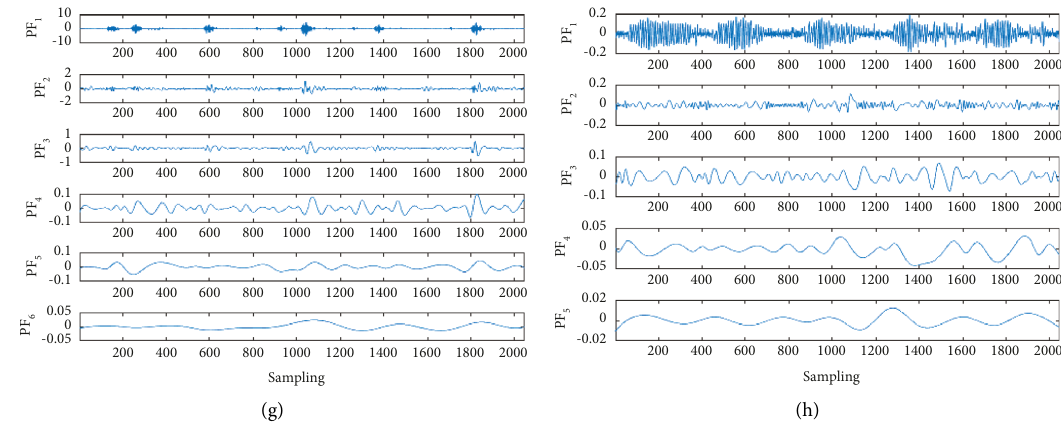
Figure 9: FF1–PF6 signal of the 8 bearing states: (a) PF1–PF6 signal of LMD on fm 1. (b) PF1–PF6 signal of LMD on fm 2. (c) PF1–PF6 signal of LMD on fm 3. (d) PF1–PF6 signal of LMD on fm 4. (e) PF1–PF6 signal of LMD on fm 5. (f) PF1–PF6 signal of LMD on fm 6. (g) PF1–PF6 signal of LMD on fm 7. (h) PF1–PF6 signal of LMD on fm 8 .